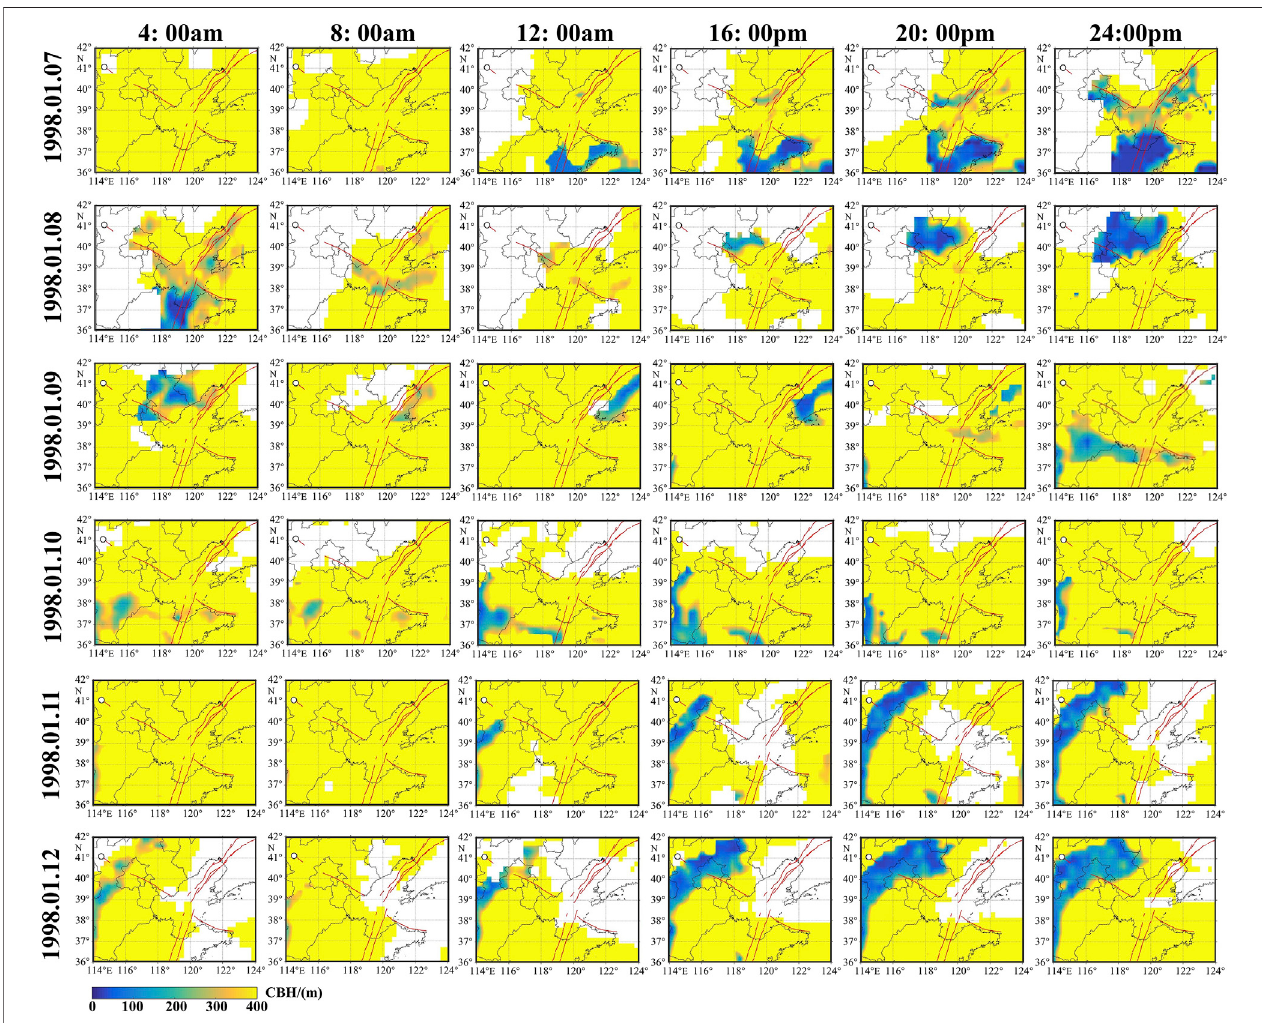
FIGURE 8 | The abnormal clouds appeared over Bohai Sea from 7 to 12 January 1998.